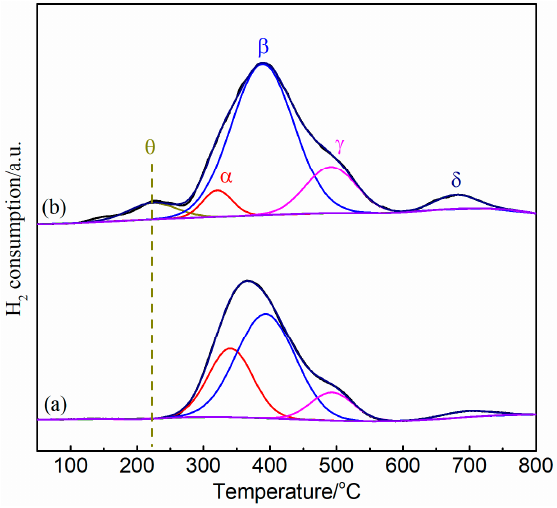
Figure 7. H 2 -TPR profiles for Ni/Bentonite-U (a) and Ni-2wt%Mn/Bentonite-U (b) catalysts. Table 3. Temperatures and area distributions of reduction peaks of Ni/Bentonite-U and Ni-2wt%Mn/ Bentonite-U